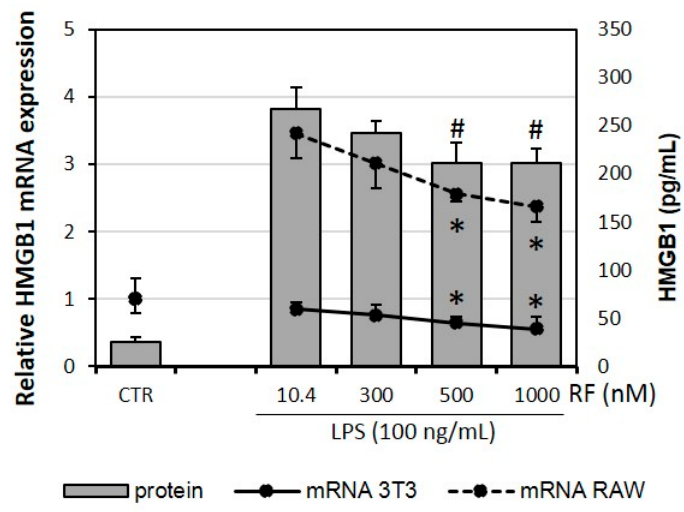
Figure 3. Effects of various riboflavin concentrations (10.4; 300; 500; 1000 nM) on LPS-induced HMGB1 mRNA expression and release by adipocyte-macrophage co-cultures. Fully differentiated adipocytes 3T3 L1 and macrophages RAW 264.7 were cultured in 12-well dishes with inserts (0.4 µ m pore size) for 6 h (mRNA expression) or 24 h (HMGB1 release) after LPS stimulation (100 ng/mL). CTR – control group without LPS stimulation. The results are expressed as means + SE of five independent experiments (* p < 0.05 significance compared with 10.4 group for HMGB1 mRNA expression; # p < 0.05 significance compared with 10.4 group for HMGB1 release to supernatant). Statistical differences were determined with the Duncan t-test.